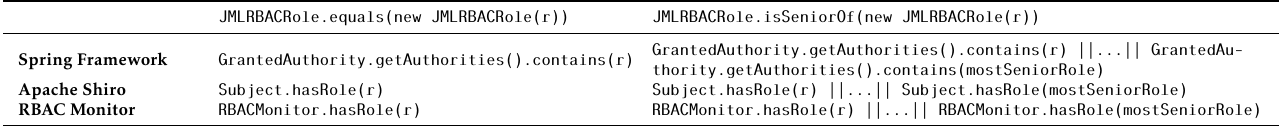
Table 5. Mappingbetweenthe JMLRBACand